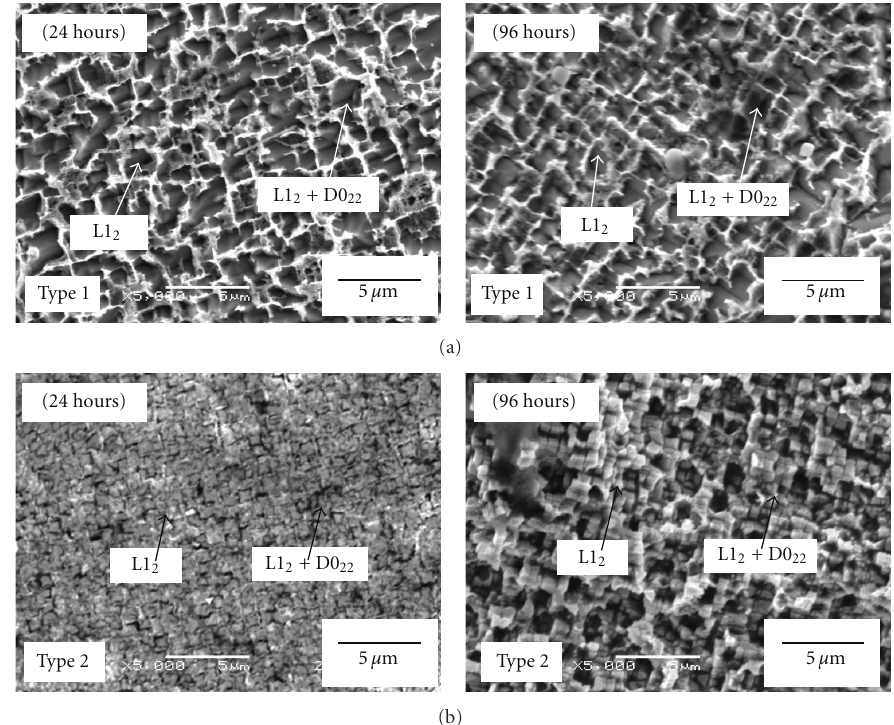
Figure 7: SEM microstructures of Ni 3 Al/Ni 3 V two-phase intermetallic compounds: (a) type 1 and (b) type 2 after the immersion times of 24 hours and 96 hours in 0.5 kmol/m 3 HNO 3 solution at 303